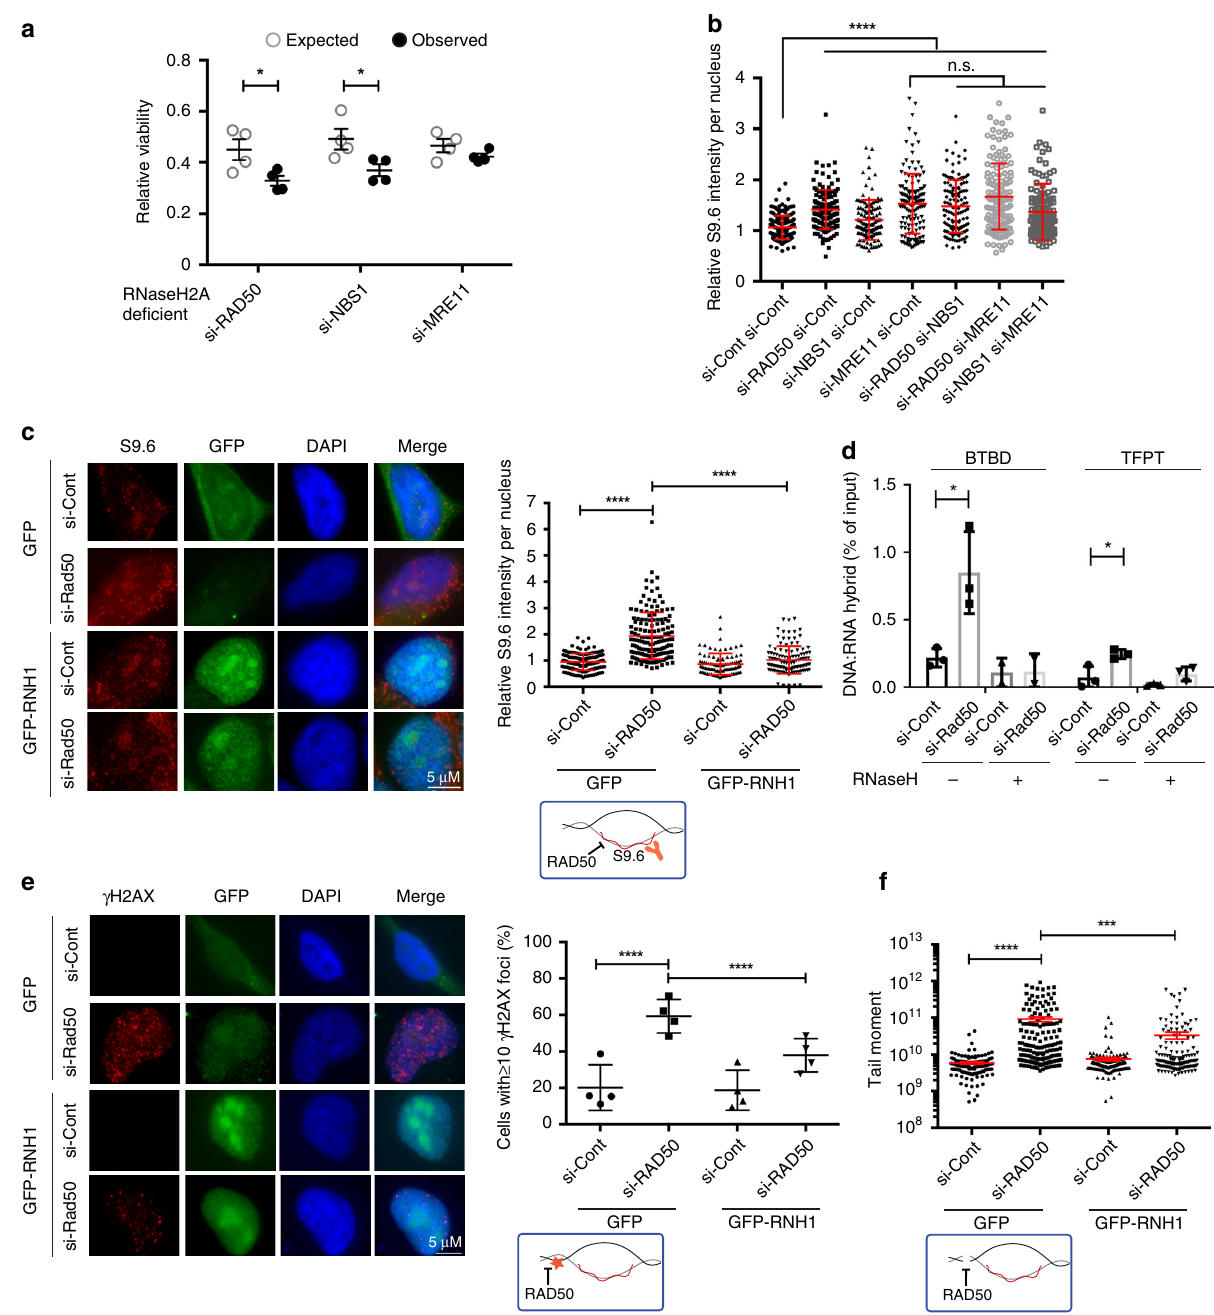
Fig. 2 Conserved RNaseH-dependence and R-loop accumulation in human cells depleted for MRN. a Cell viability of RNaseH2A normal and knockout cells depleted for RAD50 , MRE11, or NBS1 as measured by crystal violet stain ( N = 4; * P < 0.05 by t test; mean ± SEM) showed observed viability values were signi fi cantly lower than expected values after depletion of RAD50 and NBS1 . b Relative S9.6 staining intensity per nucleus in MRN complex depleted cells. N = 3; **** P < 0.0001 by ANOVA; mean ± SD. c Representative images (left) and quanti fi cation (right) of S9.6 staining per nucleus in HeLa cells treated with si-Cont or si-RAD50. Cells were transfected with either a control vector (GFP) or one expressing GFP-RNaseH1 (GFP-RNH1). N = 3; **** P < 0.0001 by t test; mean ± SD. d DRIP-qPCR analysis of R-loop accumulation at BTBD and TFPT loci in control and si-RAD50 cells with or without RNaseH treatment before precipitation. N = 3; * P < 0.05 by t test; mean ± SEM. e and f RNaseH1-dependent DNA damage phenotypes in RAD50-depleted cells shown by γ - H2AX staining and neutral comet assay for DNA breaks. e γ -H2AX staining ( N = 4; **** P < 0.0001 by Fisher ’ s exact test; mean ± SD) and f neutral comet assay ( N = 3; *** P < 0.001 and **** P < 0.0001 by t test; mean ± SEM). For c – f and some panels in subsequent Figs. (3b, 4a, 5a, and 6), cartoon schematics of an R-loop illustrate the effects being tested by the experiment are